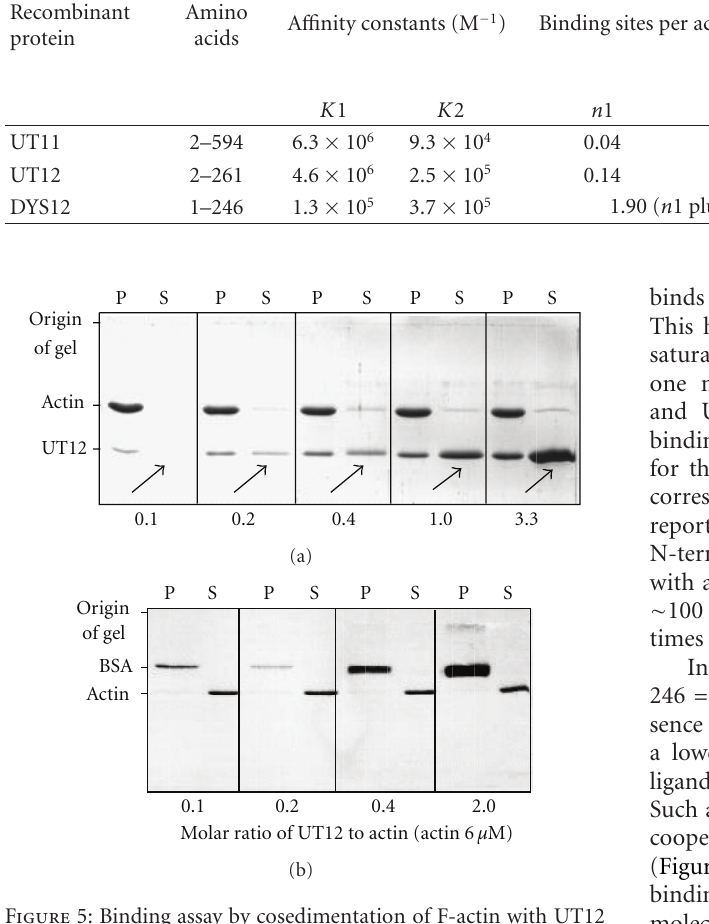
Figure 5: Binding assay by cosedimentation of F-actin with UT12 and BSA for control. 10% SDS-PAGE with protein staining by Coomassie brilliant blue R250. Pellet (P) and supernatant (S) fractions with di ff erent molar ratios of UT12 (a) or BSA (b) to actin in the presence of 2mM MgCl 2 and 0.5mM CaCl 2 . UT12 and BSA varied from 0.6 up to 19 μ M. Actin was held constant at 6 μ M. The positions of UT12, BSA, and actin are indicated at the left. Arrows point to unbound UT12 in the supernatant. At all concentrations, no BSA was bound to